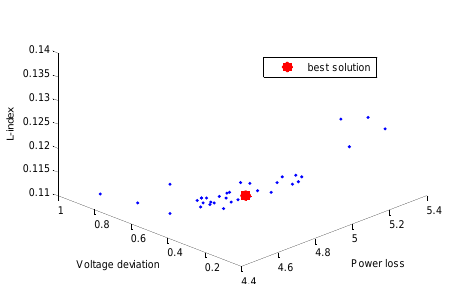
Figure 4. Pareto optimal front of the proposed approach